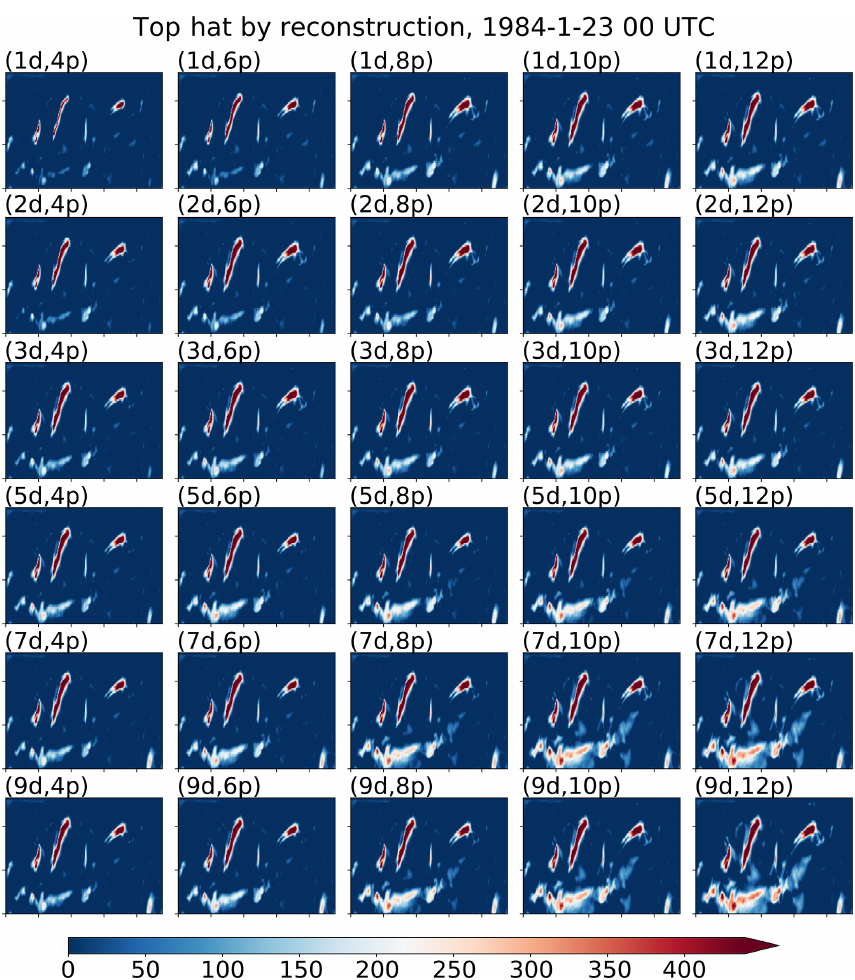
Figure 3. IVT anomalies (in kgm − 1 s − 1 ) from the THR process on 23 January 1984 at 00:00UTC. Subplots are results obtained using different combinations of the time ( t ) and space ( s ) parameters of the 3-D structuring element in the THR process, and the subplots are labeled in a format of ( t d, s p), with d being short for “days” and p for “pixels”. From row 1 to row 6, t increases from t = 1 to t = 9d. From column 1 to column 5, s increases from s = 4pixels to s = 12pixels, with a step of 2. Axes’ information has been omitted for brevity, and the domain is the same as in Fig.